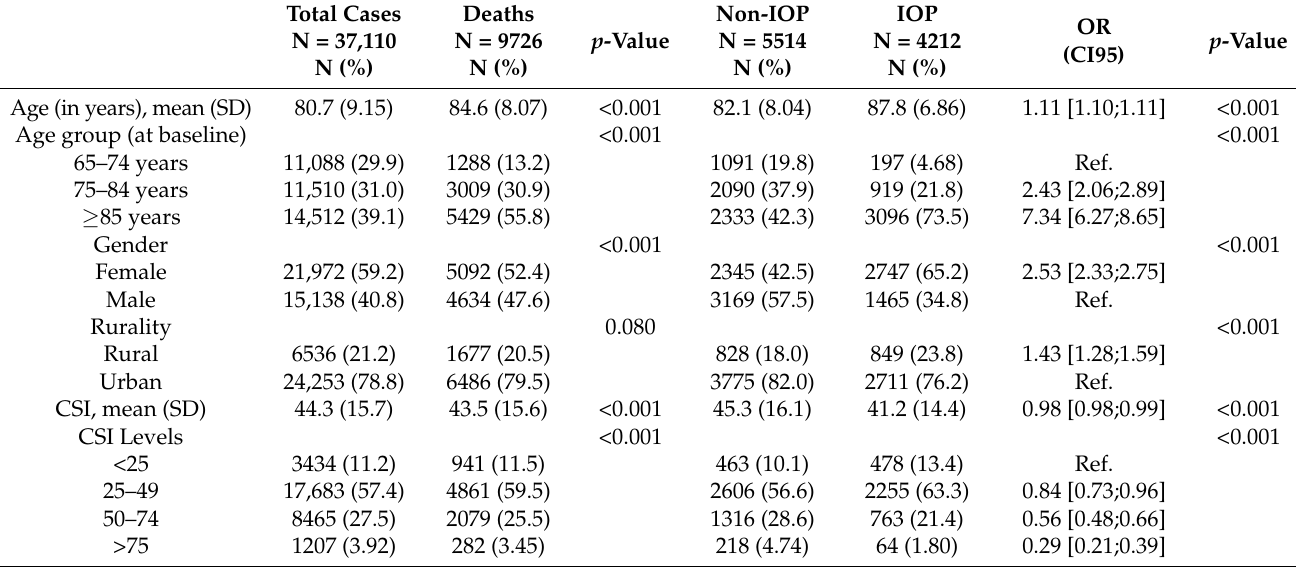
COVID-19 deaths among detected cases comparing institutionalised and non- institutionalised